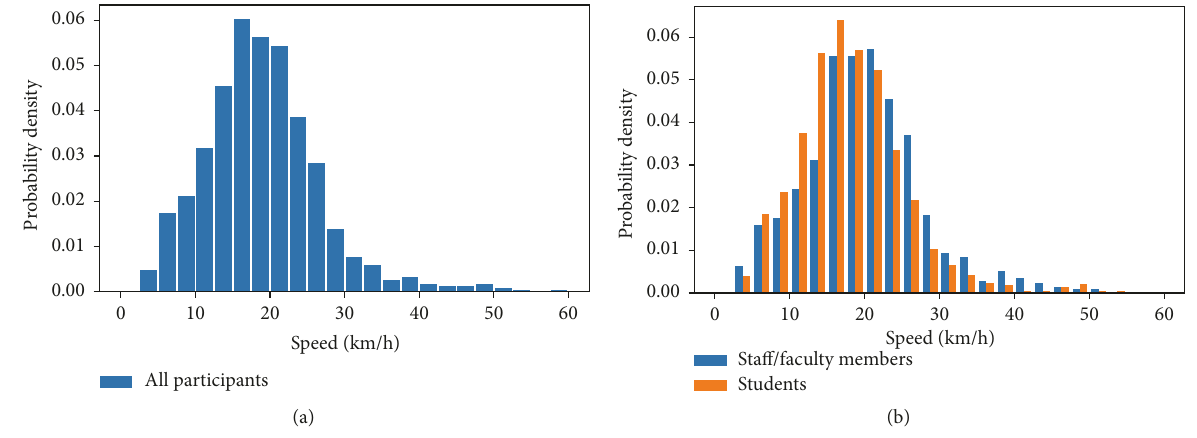
Figure 4: Probability distribution of the average trip speed in km/h (a) for all participants, (b) split by occupation.